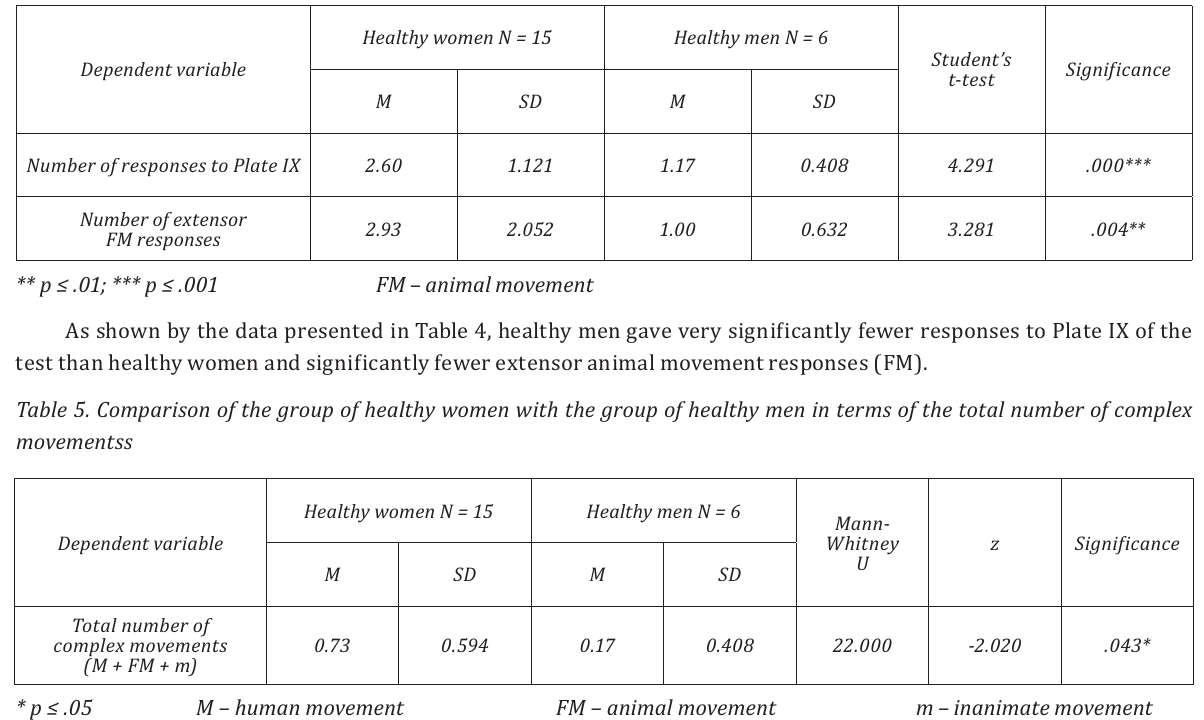
Table 4. Differences and the significance of differences in selected variables between the groups of healthy women and healthy men